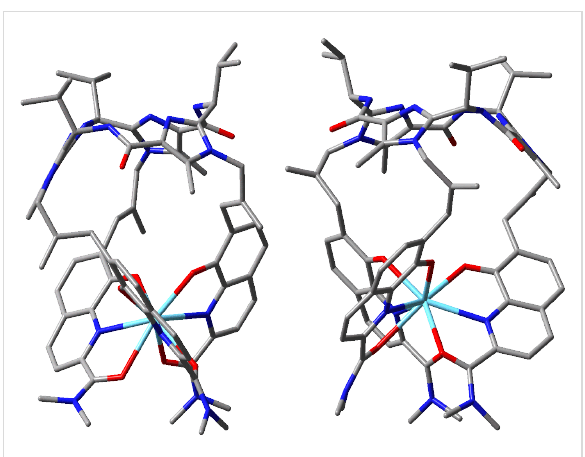
Figure 6: Molecular structures of the Λ2 (left) and Δ2 (right) isomers of complex 1b· La calculated by using B3LYP/LANL2DZ. All hydrogen atoms were omitted for clarity.